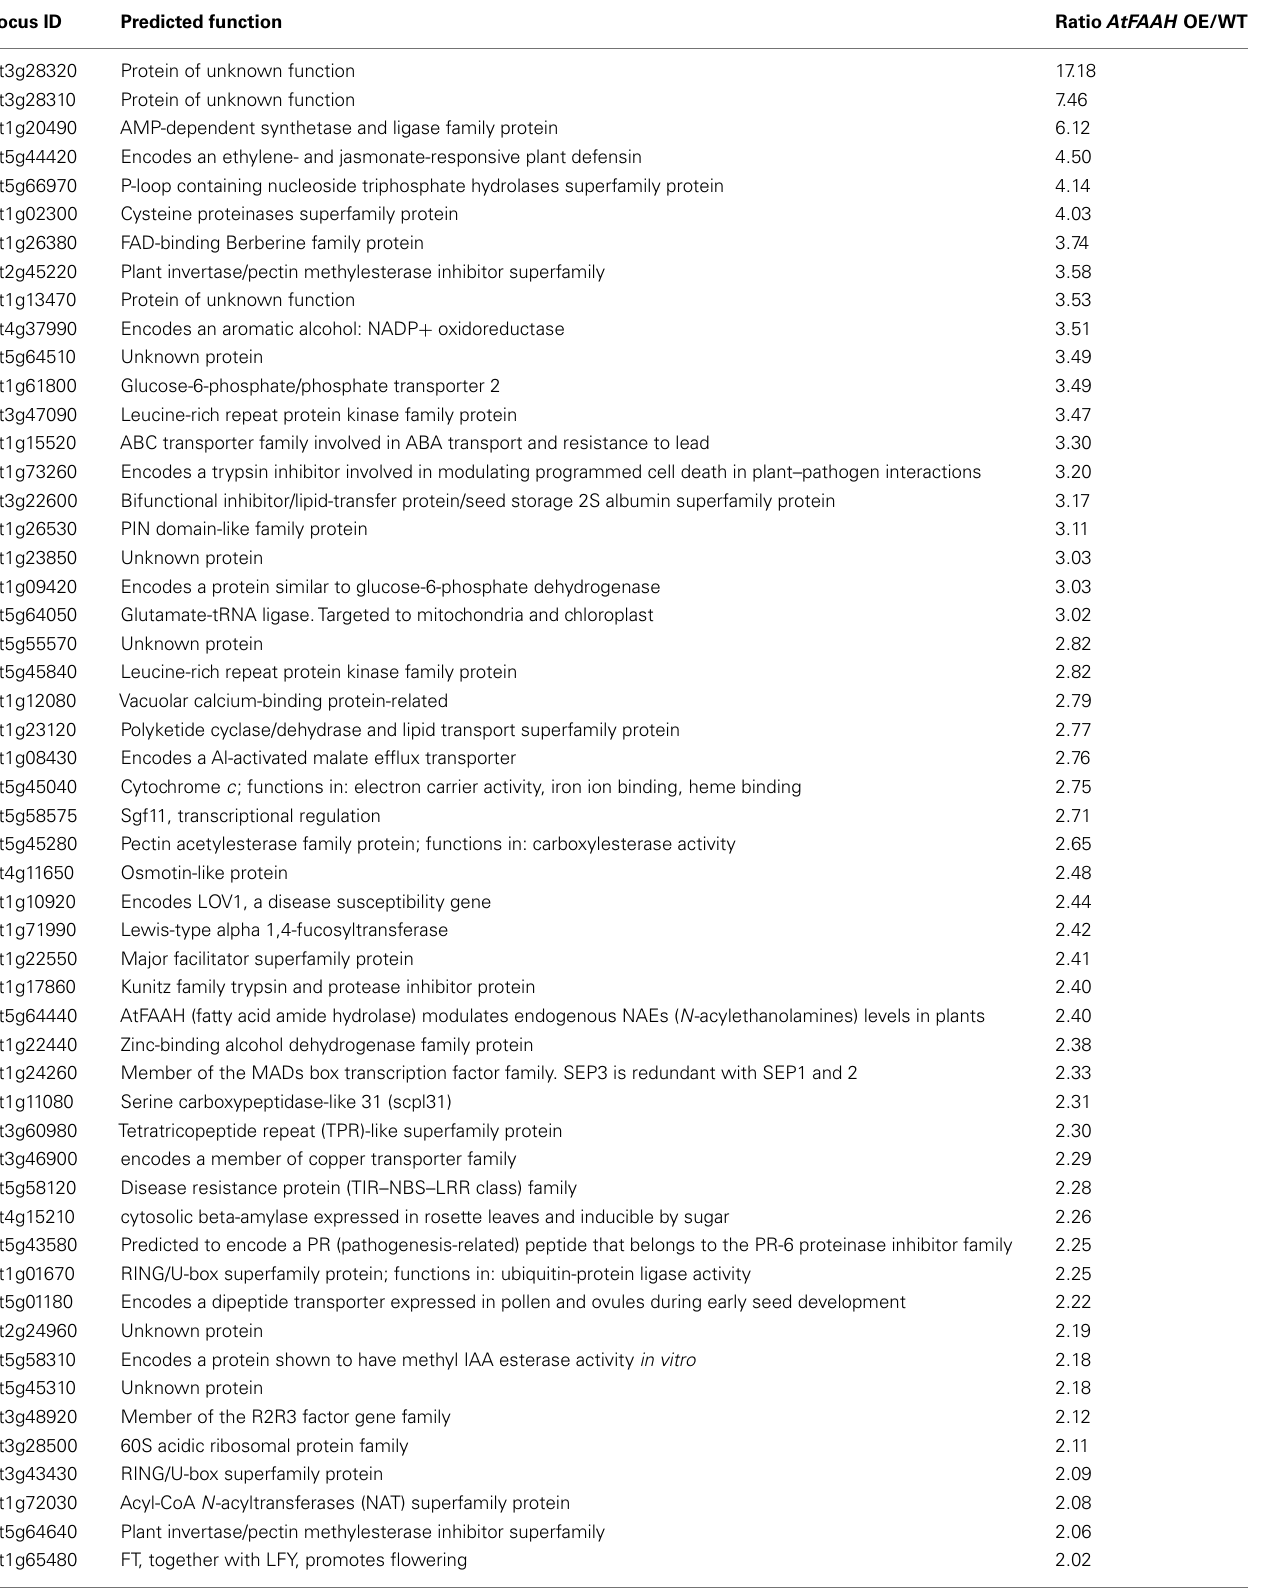
Table 1 | Genes induced twofold or more in AtFAAH overexpressors compared to wild